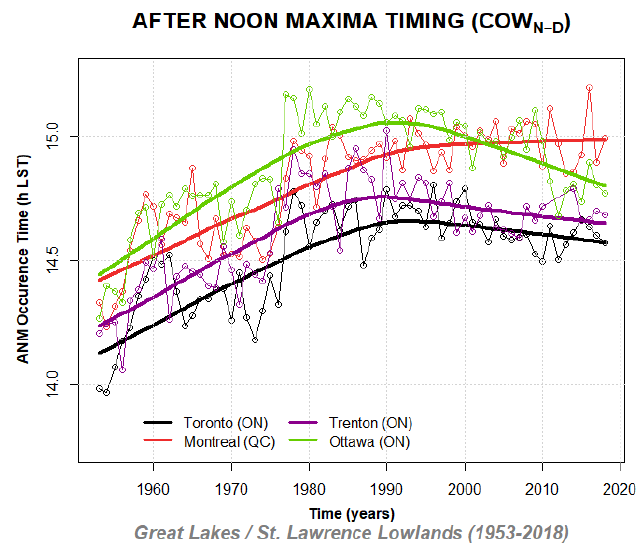
Figure 11. Annually averaged DET ANMt x for Great Lakes/St. Lawrence Lowlands stations with variable positive shifts in After Noon Maxima timing occurrence.